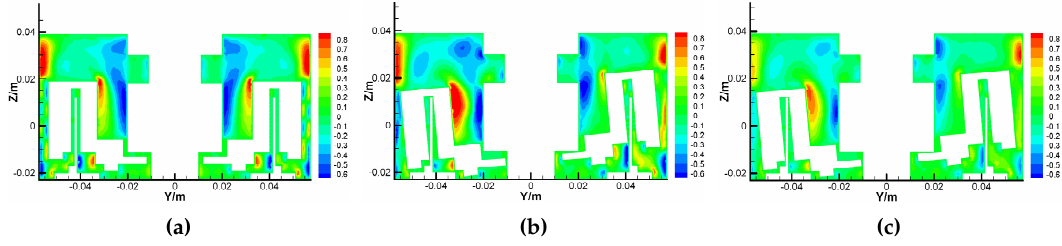
Figure 11. Axial velocity contours of the GyroWheel under φ y = 0 ◦ . ( a ) Results under φ x = 0 ◦ and